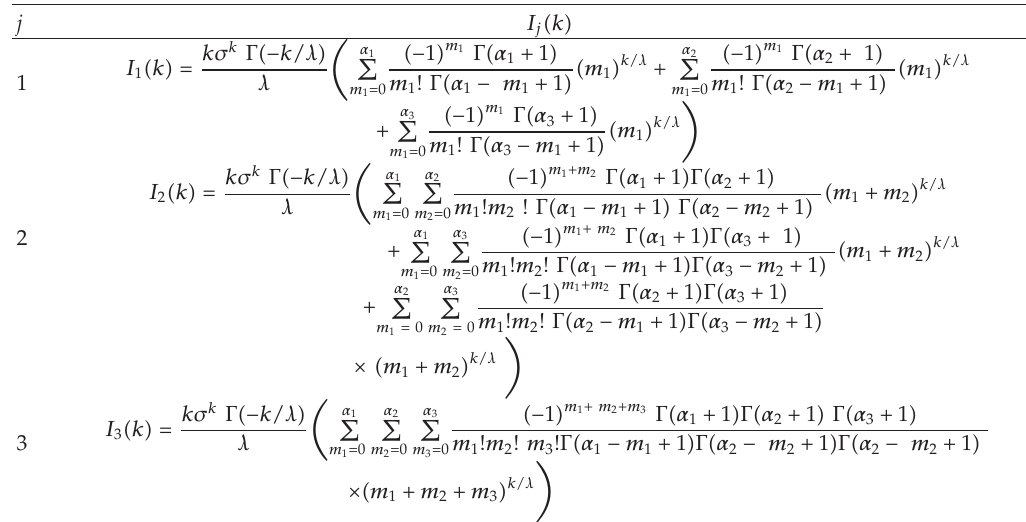
Table 1: I j (cid:2) k (cid:3) using (cid:2) 3.3 (cid:3) when n (cid:6) 3. j I j (cid:2) k (cid:3)